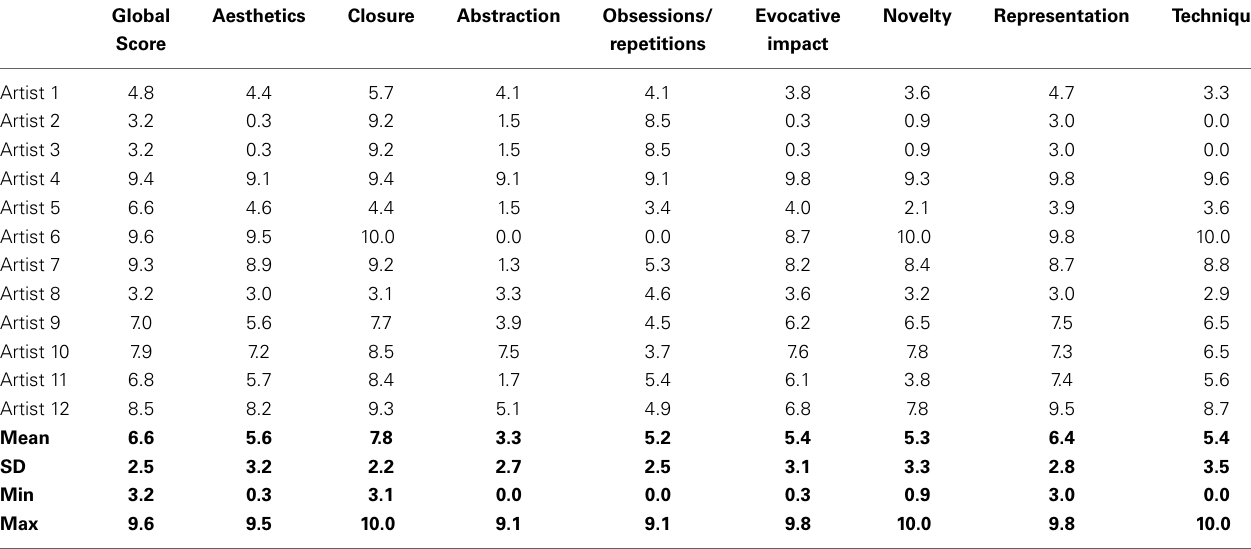
Table 5 | CAT assessment of the drawings from patient YCFZ (2010–2013).